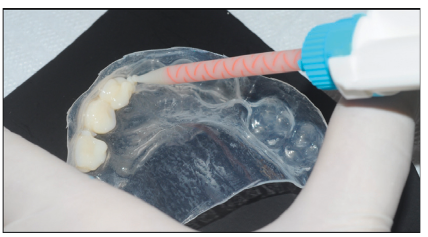
Figure 5: Silicone tray being loaded with Protemp 4 (3M ESPE).